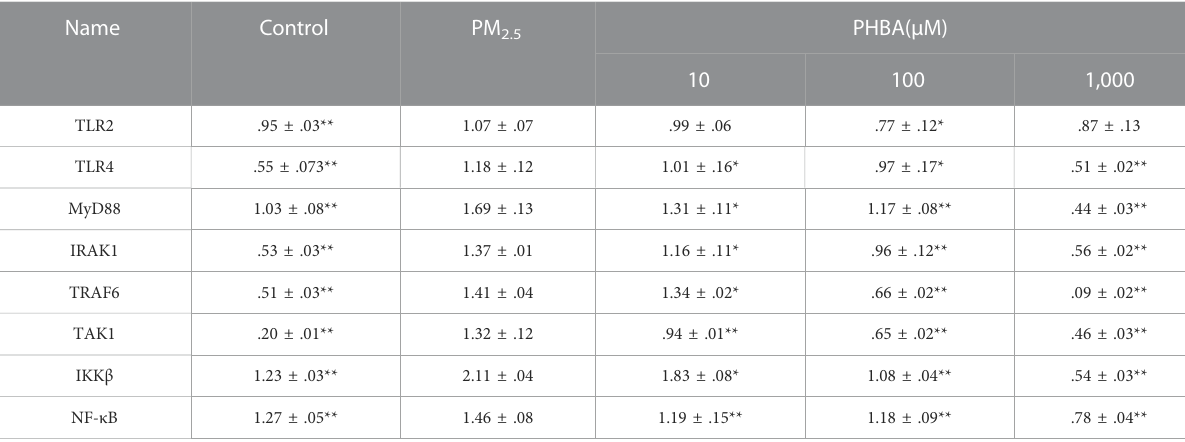
TABLE 2 Effects of PHBA on gene expression in TLRs related pathways.